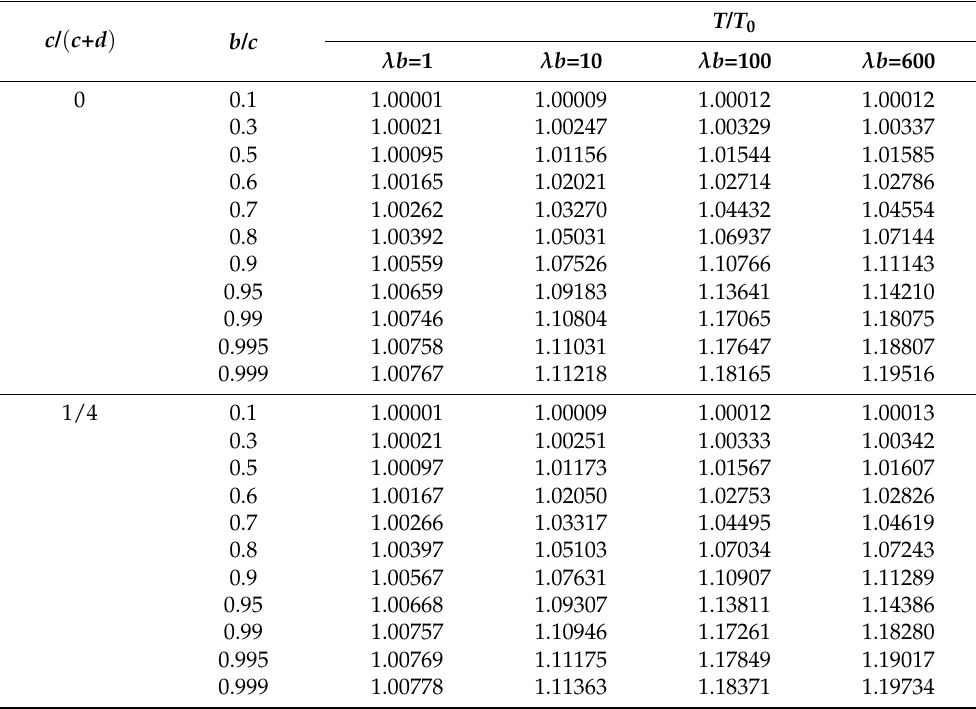
Table A1. Normalized torque T / T 0 for a porous sphere ( a = 0) rotating about a diameter perpendic- ular to two parallel planar